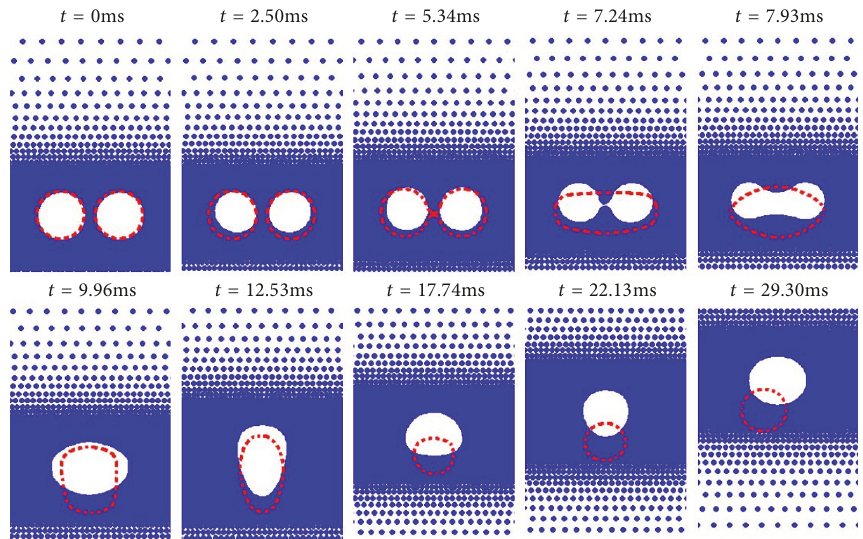
Figure 12: Shape change of bubble pairs coalescence process under pulsation/static condition (red-dashed line).